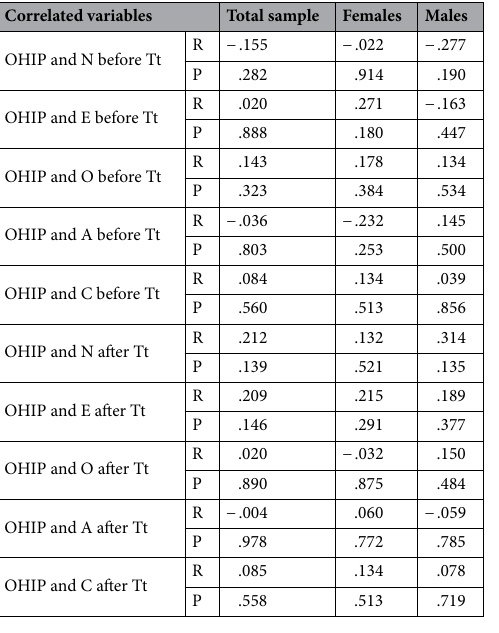
Table 4. Correlations between OHIP and NEO-FFI scores before and after treatment among the study population (n = 50, 26 females and 24 males). OHIP = Oral Health Impact Profile scores, Before Tt = Before treatment, After Tt = After treatment, N = Neuroticism, E = Extraversion, O = Openness, A = Agreeableness, C = Conscientiousness, R = Pearson’s Correlation Coefficient, P = Two tailed probability